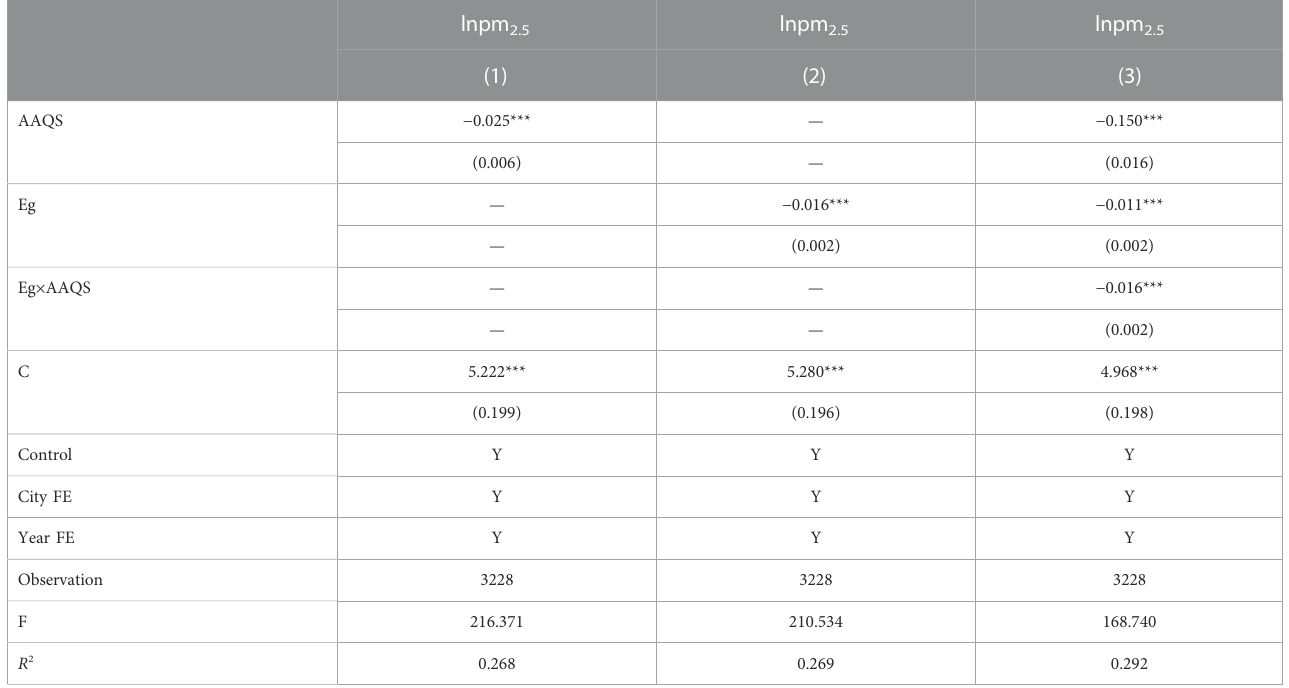
TABLE 6 The moderating effect of government environmental